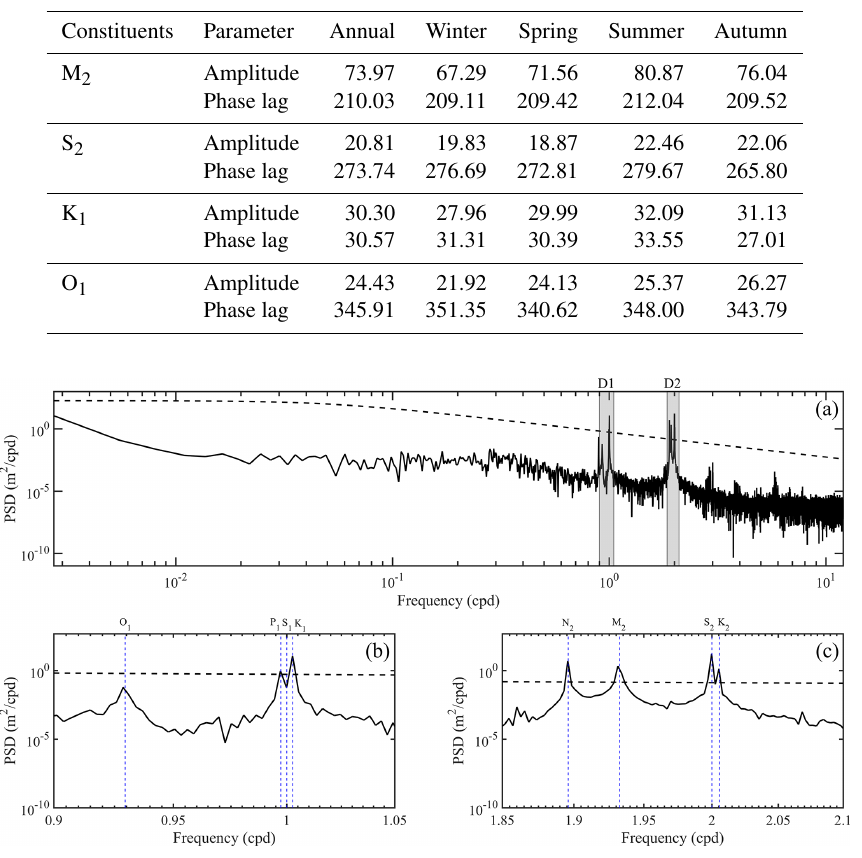
Figure 5. Similar to Fig. 3 but for those at